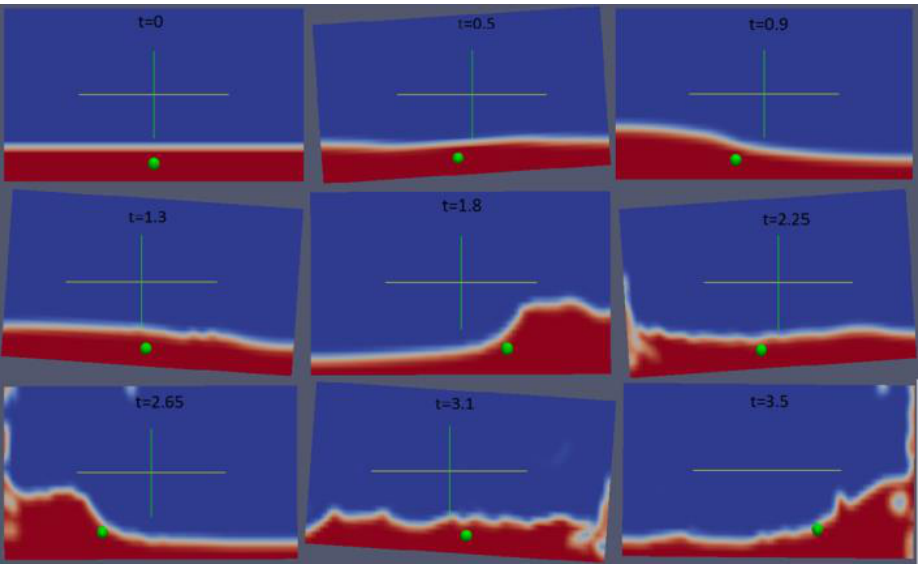
Figure 9. Center of mass and air–liquid interface.